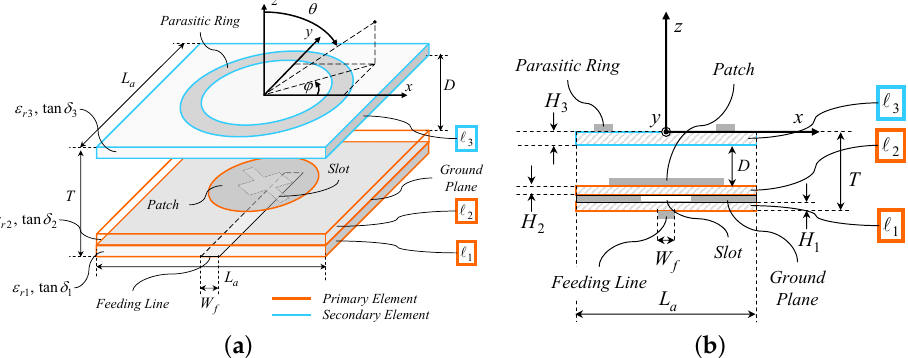
Figure 1. WWCS Antenna Layout —Geometry sketch of the proposed WWCS radiator: ( a ) 3D and ( b ) lateral view.